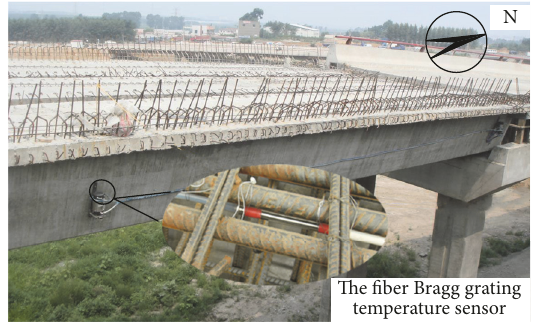
Figure 18: View of the bridge and the temperature